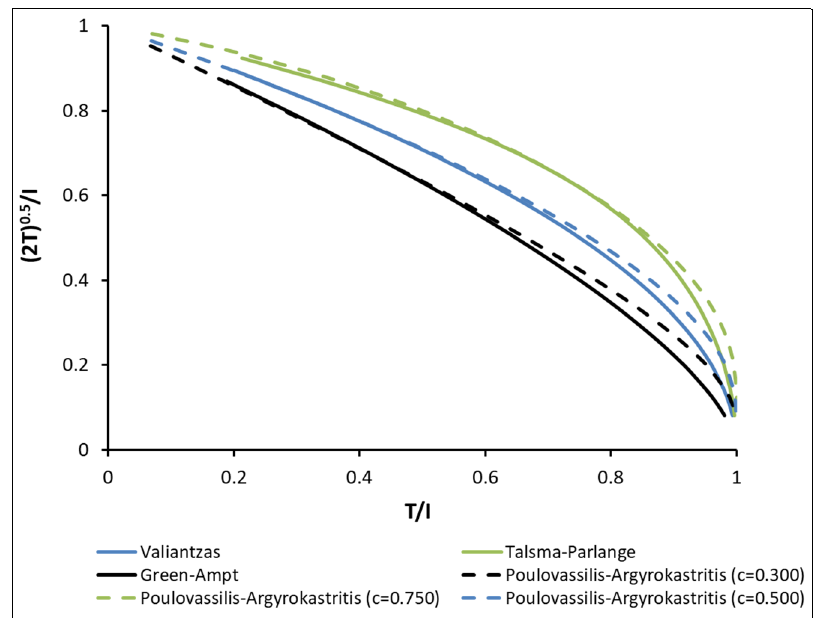
Figure 2. The relative weighed effect of pressure head gradient in dimensionless form (2T) 0.5 /I as a function of T/I (relative weighed effect of gravity) according to equations of Green–Ampt, Talsma– Parlange, Valiantzas, and Poulovassilis–Argyrokastritis (Equation (9) for c = 0.300, 0.500 and 0.750).